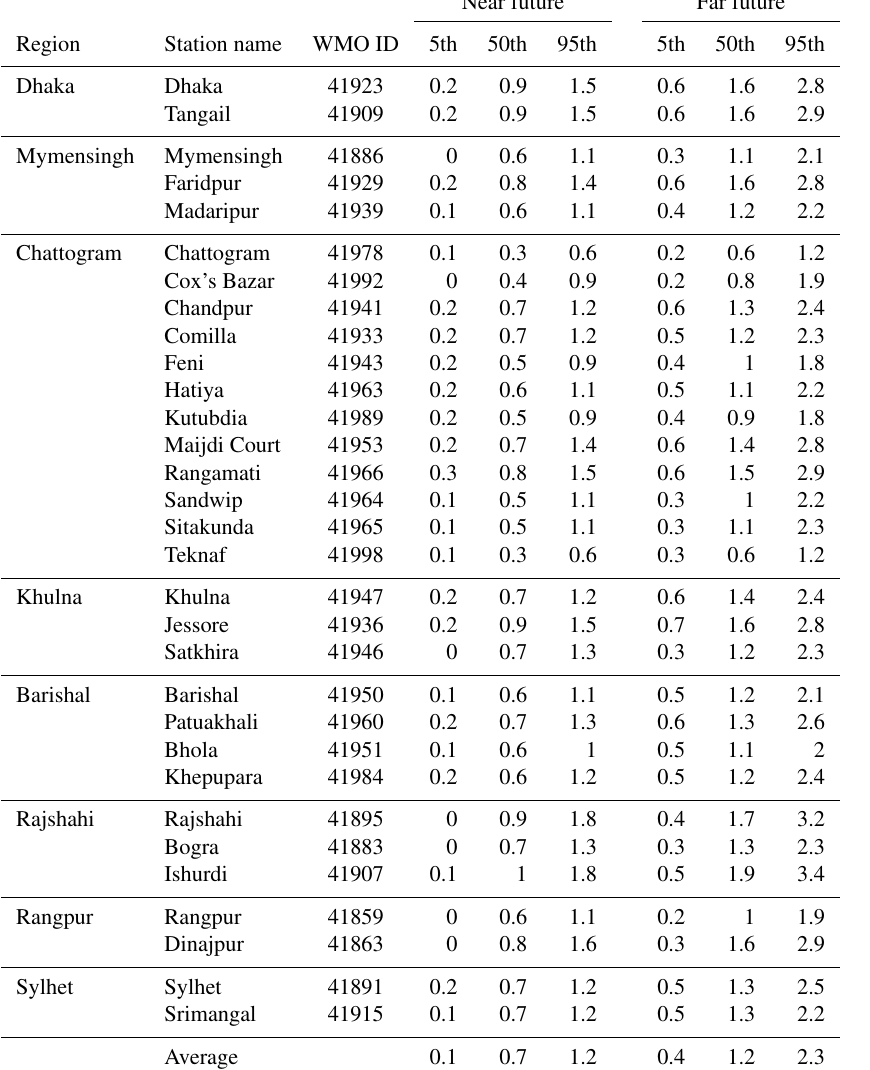
Table 3. The 5th, 50th and 95th percentile values of projected changes in maximum temperature (unit: ◦ C) in Bangladesh for the near future (2021–2050) and far future (2071–2100) relative to the 1981–2010 period for